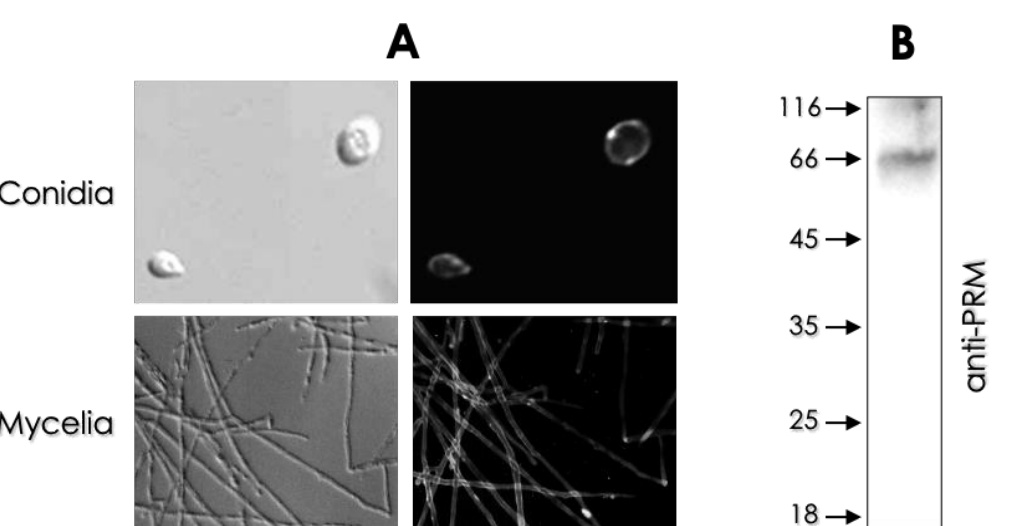
Figure 11. Detection of PRM produced by S. apiospermum. ( A ) Immunofluorescence microscopy evidencing PRM on the surface of both conidia and mycelia of S. apiospermum utilizing an anti-PRM antibody (kindly donated by Dr. Eliana Barreto Bergter from Instituto de Microbiologia Paulo de Góes and Universidade Federal do Rio de Janeiro). ( B ) Western blotting assay evidencing the presence of soluble PRM in the supernatant of S. apiospermum mycelial cells growth using anti-PRM antibody.